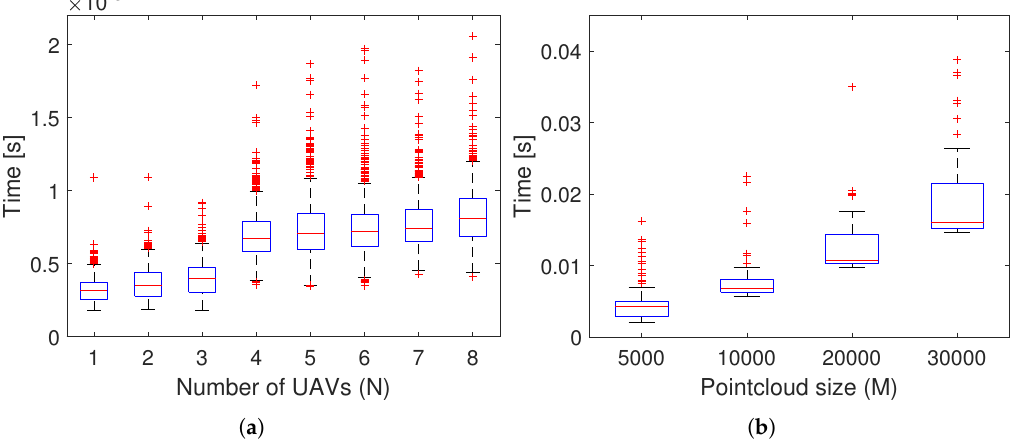
Figure 8. Scalability tests for 3D-SWAP. ( a ) 3D-SWAP execution time as the number of UAVs increases. ( b ) 3D-SWAP execution time as the pointcloud size